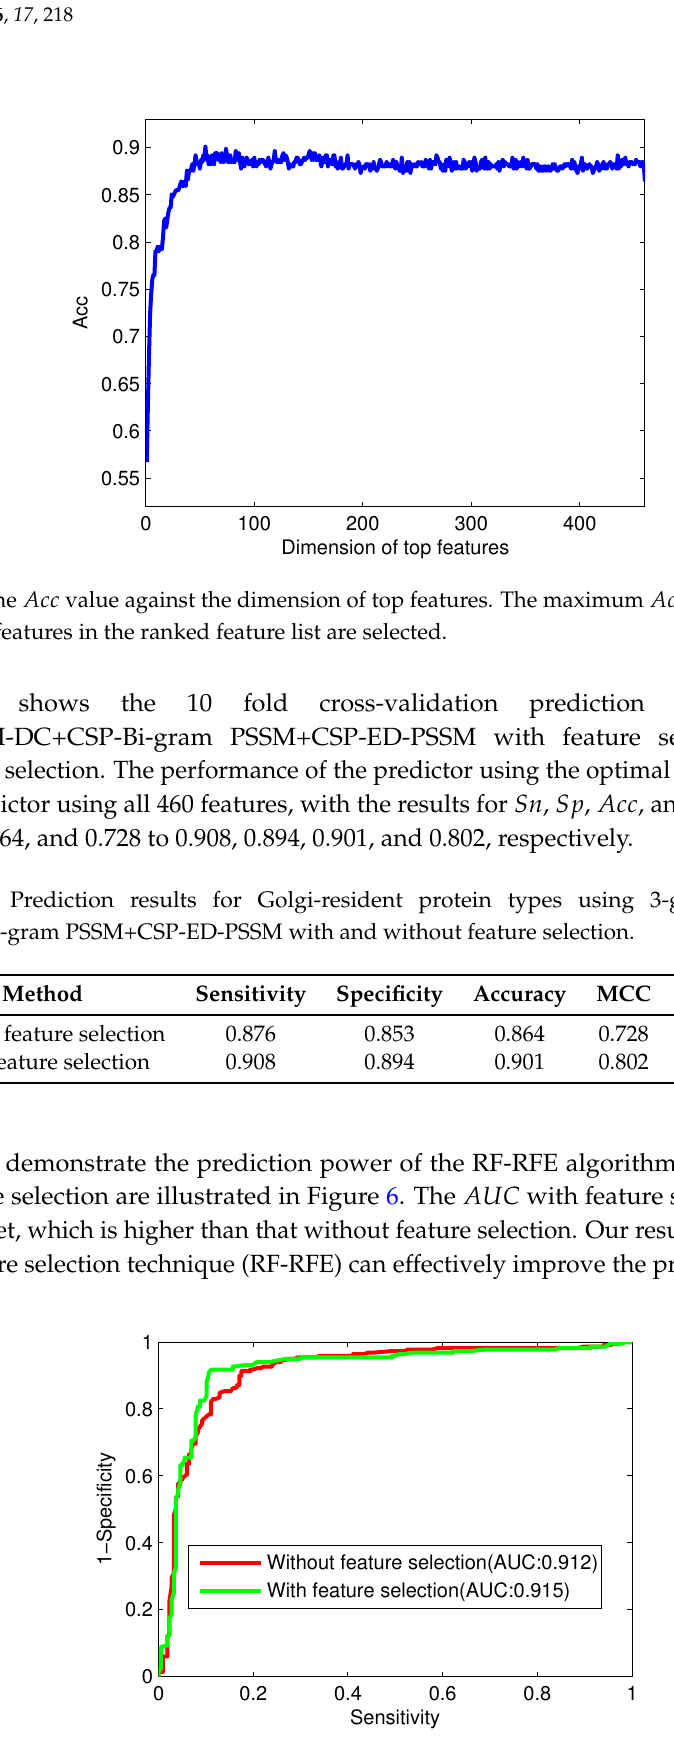
Figure 6. ROC (Receiver-Operating Characteristic) curves with and without feature